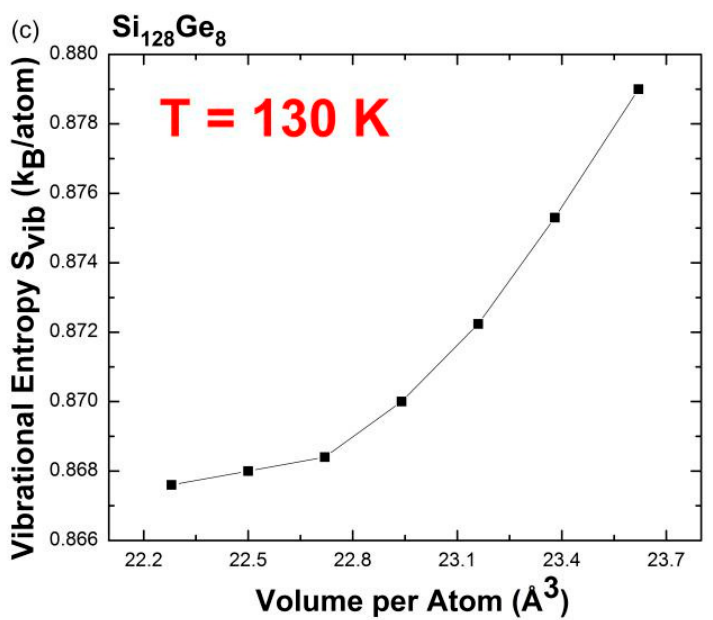
Figure 10. Predicted vibrational entropy as a function of the designated volume at ( a ) T = 40 K, ( b ) T = 80 K, and ( c ) T = 130 K for Si 128 Ge 8 .